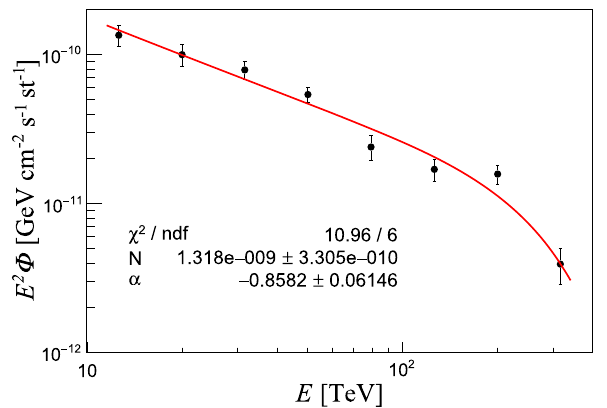
Fig. 13 Fit of the LHAASO data points with the power-law back- ground in Eq. (28). The χ 2 (cid:4) 11, showing how it is only a fit acceptable into 2 σ errors